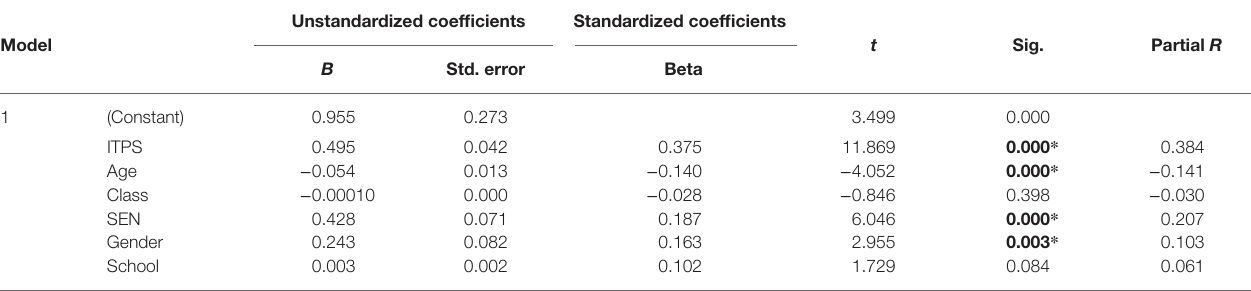
TABLE 3 | Multiple regression statistics for examining predictors of students’ perceived emotional inclusion levels.